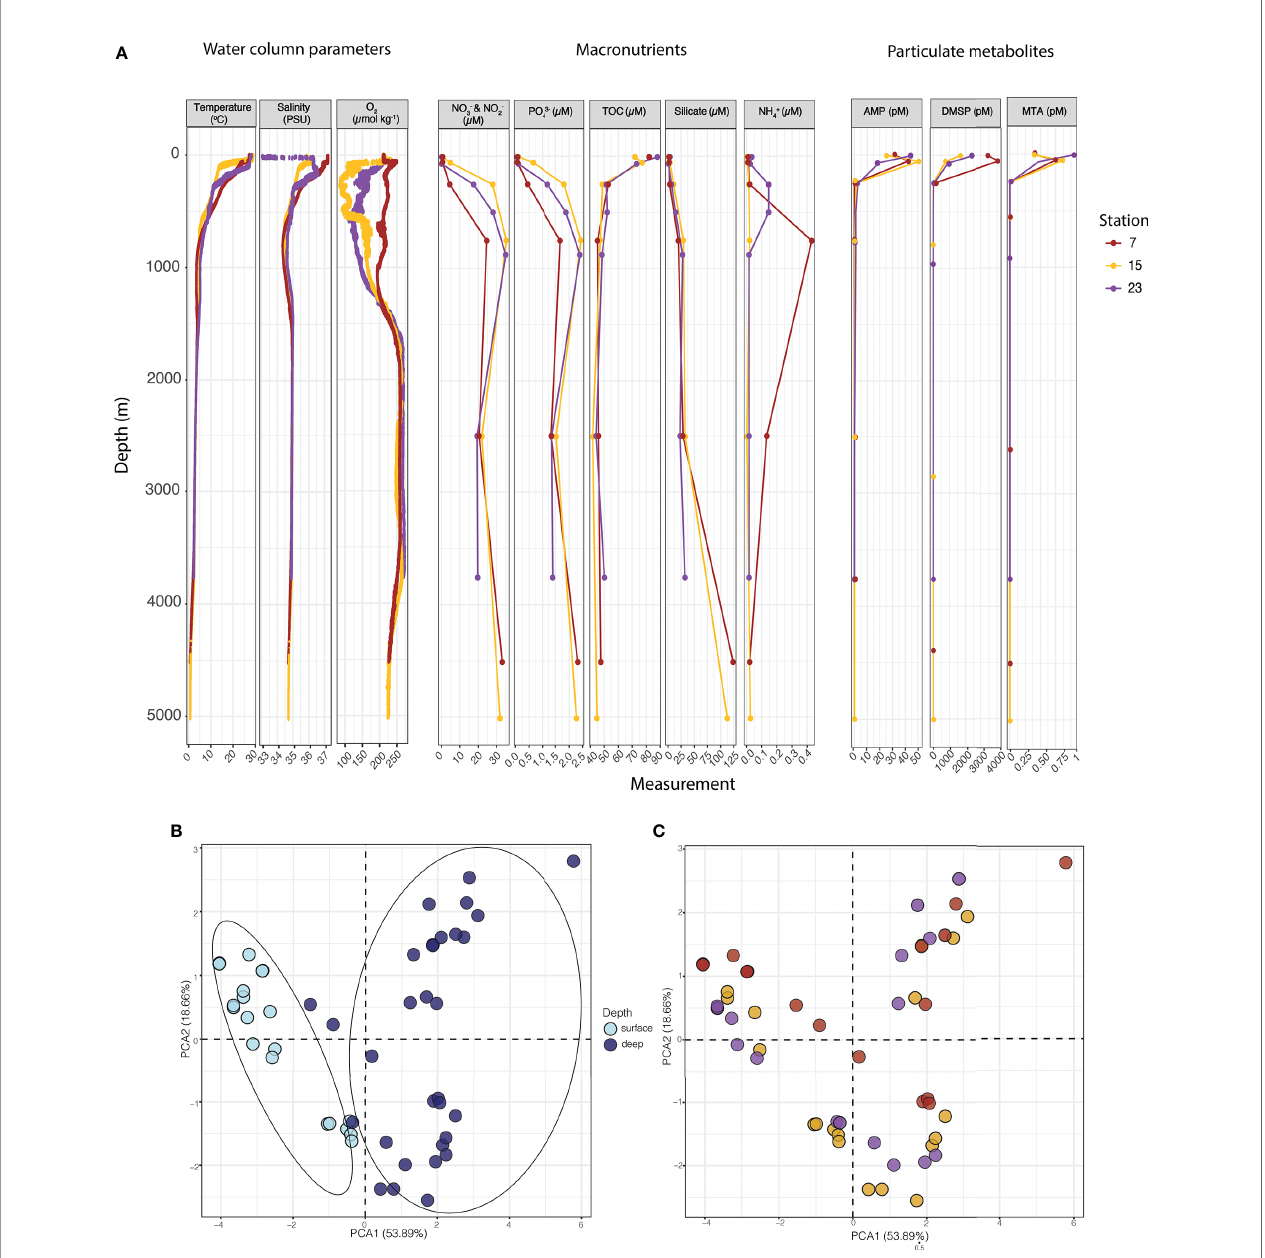
FIGURE 2 | Water column parameters and ordination patterns across station and depth. (A) Water column pro fi les of physical and chemical measurements collected at Stations 7, 15 and 23. (B) PCA ordination of water column parameters and nutrient concentrations, shown in (A) , coloured by depth. Signi fi cantly distinct environmental conditions pertain to surface (0-150 m) and deep zones (250-4000 m), shown encircled, based on an ANOSIM test (p < 0.05, R = 590). (C) the same PCA ordination as shown in (B) , with samples coloured according to station (Stations 7, 15 and 23), show non-signi fi cant groupings (ANOSIM P = 0.092, R = 0.133). Data variance explained by each PCA axis is shown in